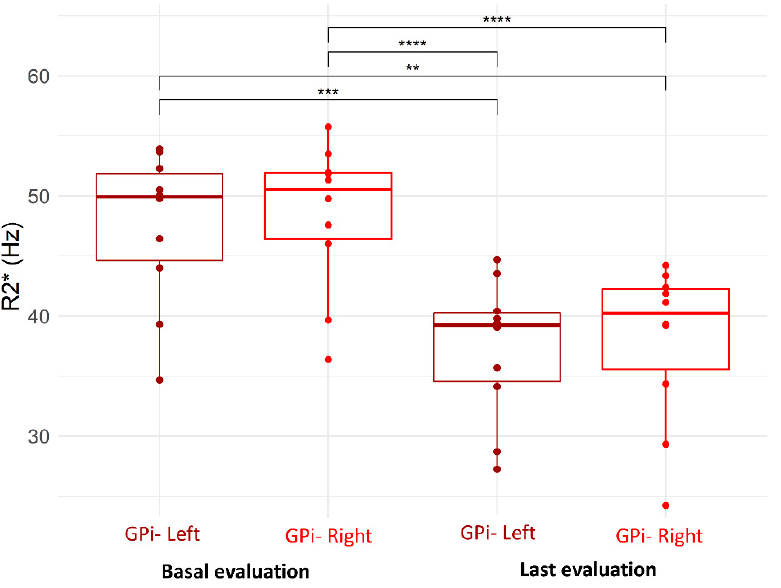
Figure 2. MRI-R2* of left and right globus pallidus internus (GPi)—comparison between basal and last evaluation (“**” p ≤ 0.01; “***” p ≤ 0.001; “****” p ≤ 0.0001) .